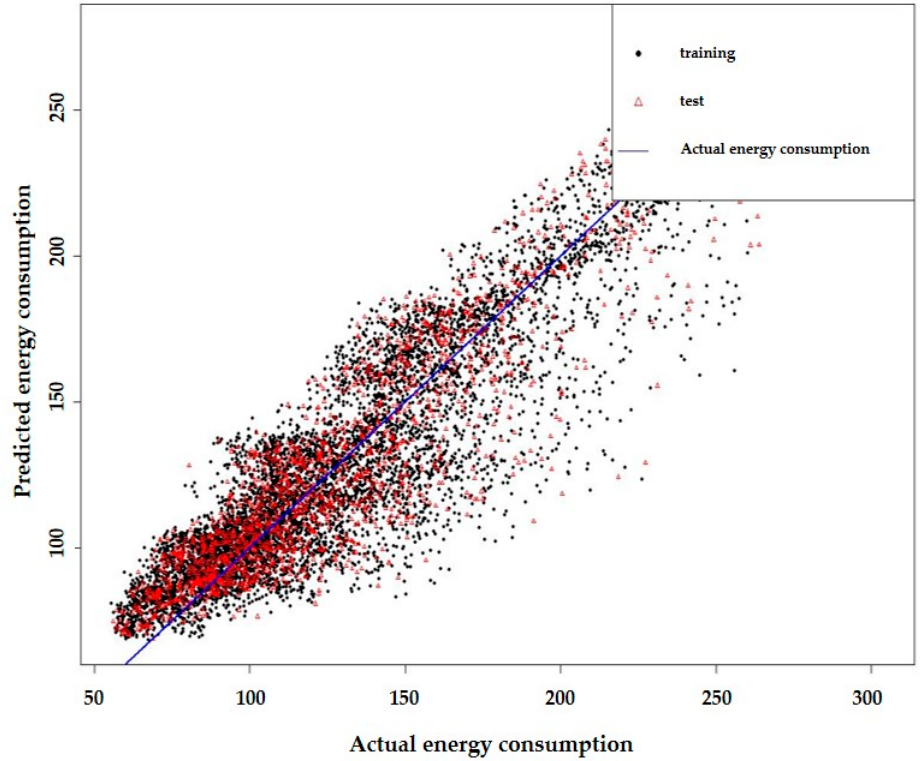
Figure 9. Results of a regression analysis of the major variables.